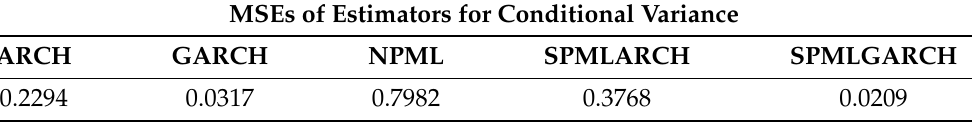
Table 1. The table shows MSEs calculated by Equation (14) for the ARCH, GARCH, NPML, SPM- LARCH, and SPMLGARCH models under the DGP specified in Equation (13). The sample size for each estimation is n = 200 and the number of replications is M =